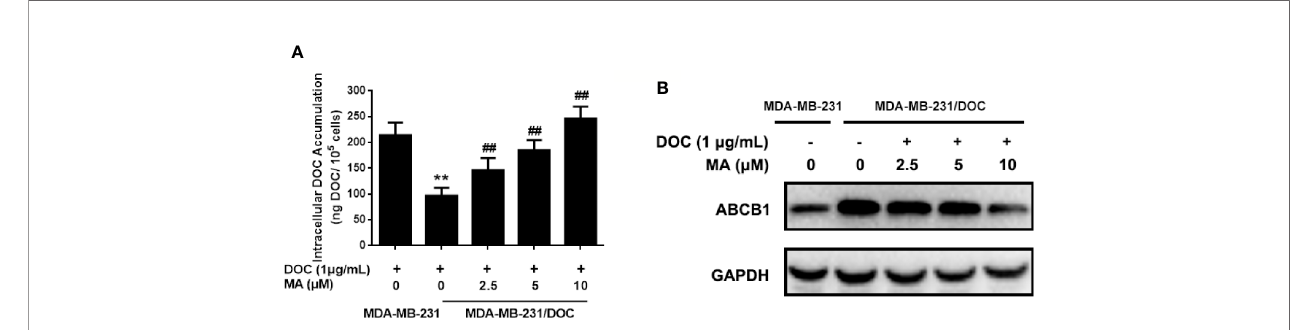
FIGURE 2 | The effect of maslinic acid (MA) on cellular docetaxel (DOC) accumulation in MDA-MB-231/DOC cells. MDA-MB-231 and MDA-MB-231/DOC cells were incubated with DOC alone or DOC combined with MA for 24 h. (A) Cell lysates were collected for testing of cellular DOC concentrations using HPLC. (B) The